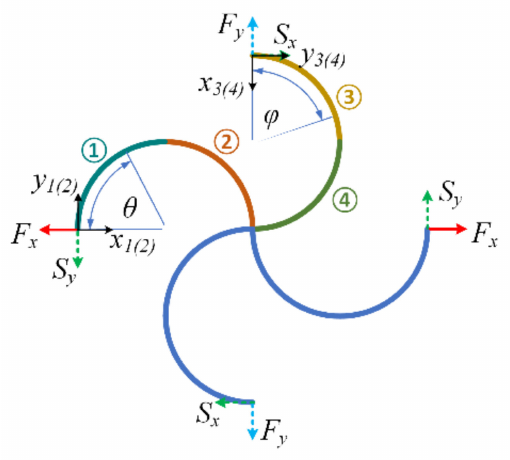
Figure 4. Unit cell under tensile loading in the